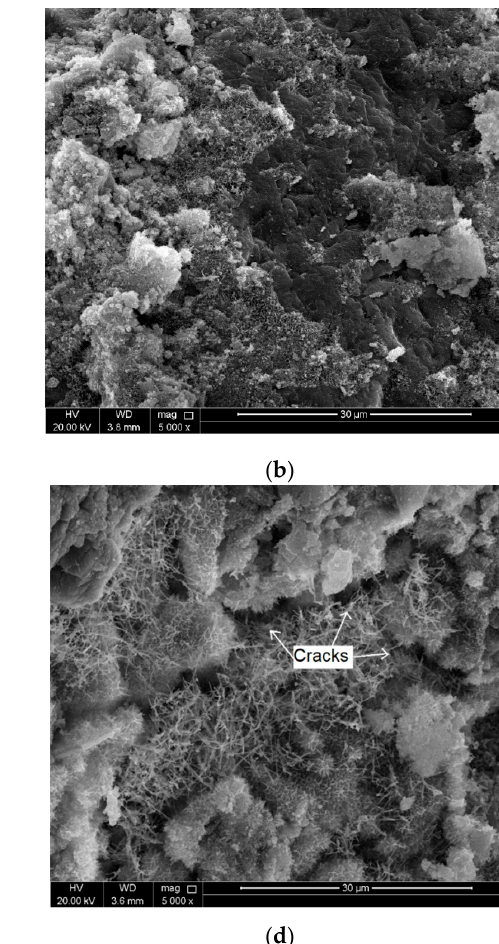
( b ) Figure 5. SEM images show the cracks bridging effect of the CNTs for mortar heated at ( a ) 200 o C; ( b ) 450 o C. 3.3. Thermal Behavior Characterization 3.3.1. Thermal Conductivity Figure 6 shows the effect of heating on the thermal conductivity of cement mortar with or without CNTs. Heat exposure of cement mortar reduced its thermal conductivity regardless of the presence of CNTs. This finding may be attributed to the deterioration of the microstructure and decomposition the hydration products of the mortar when ex- posed to elevated temperatures, as proven in the SEM images. However, specimens with CNTs owned higher thermal conductivity than that of control specimens regardless of the heating level. This finding agrees with other results reported in [29] and could be ascribed to: (1) The well distribution of the CNTs, which owned higher conductivity than cement